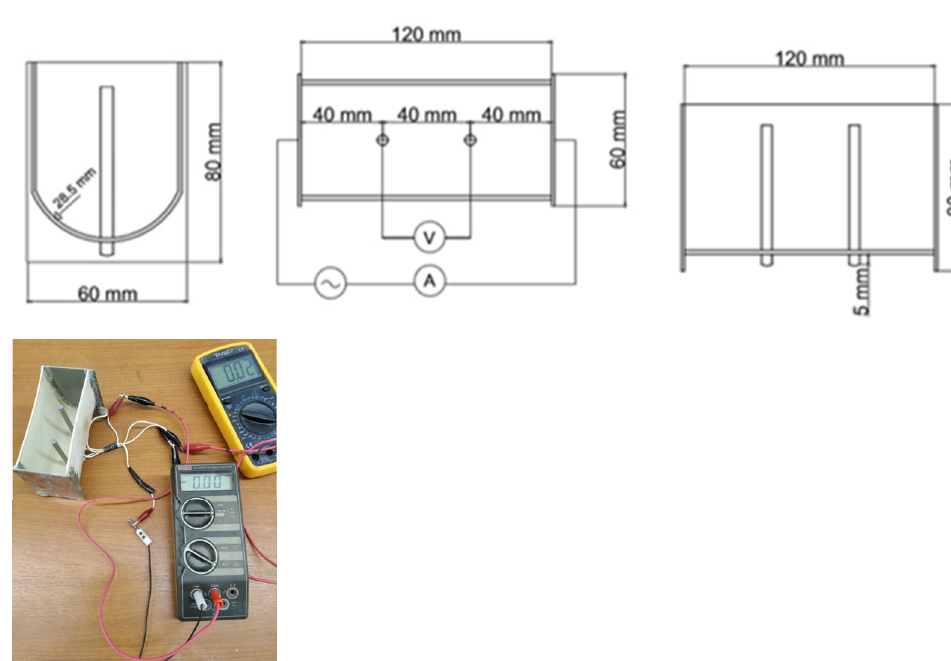
Figure 2. Scheme and photo of the device.